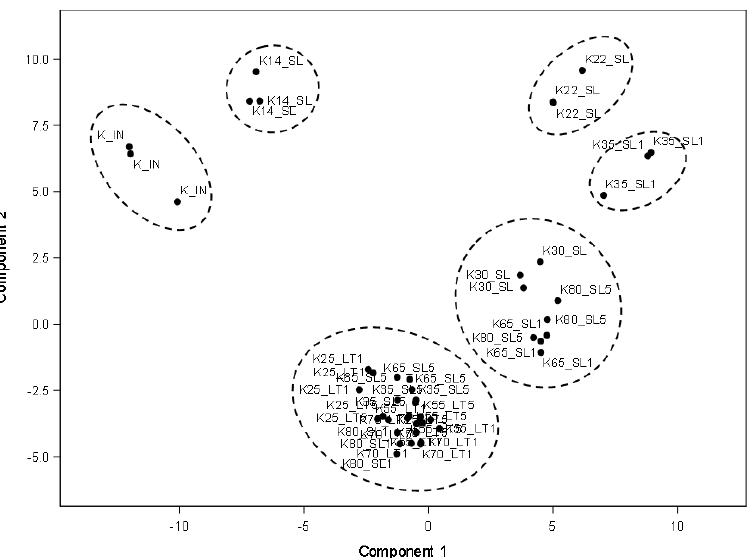
Figure 6. Score plot of PC1 and PC2 for cultivar ‘Conference’ ripening in different storage regimes. (K-‘Conference’; IN-storage start; 14, 22, 25, 30, 35, 55, 65, 70, 80-storage days; LT1, LT5-low storage at 1 or 5 °C; SL-shelf life at 20 °C; SL1, SL5-shelf life at 20 °C after storage at 1 or 5 °C).